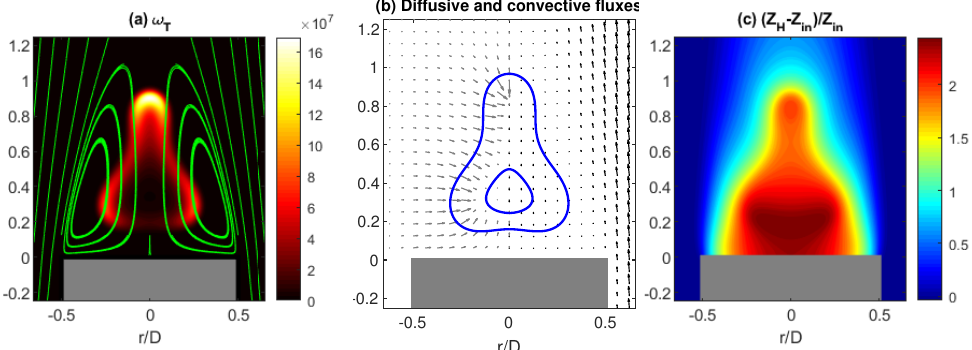
Figure 10. ( a ) Heat release contour along with streamlines for the residual flame at φ = 0.11; ( b ) Diffusive ( left ) and convective ( right ) flux of H 2 ; ( c ) Scaled hydrogen elemental mass fraction Z H − Z H , in Z H , in